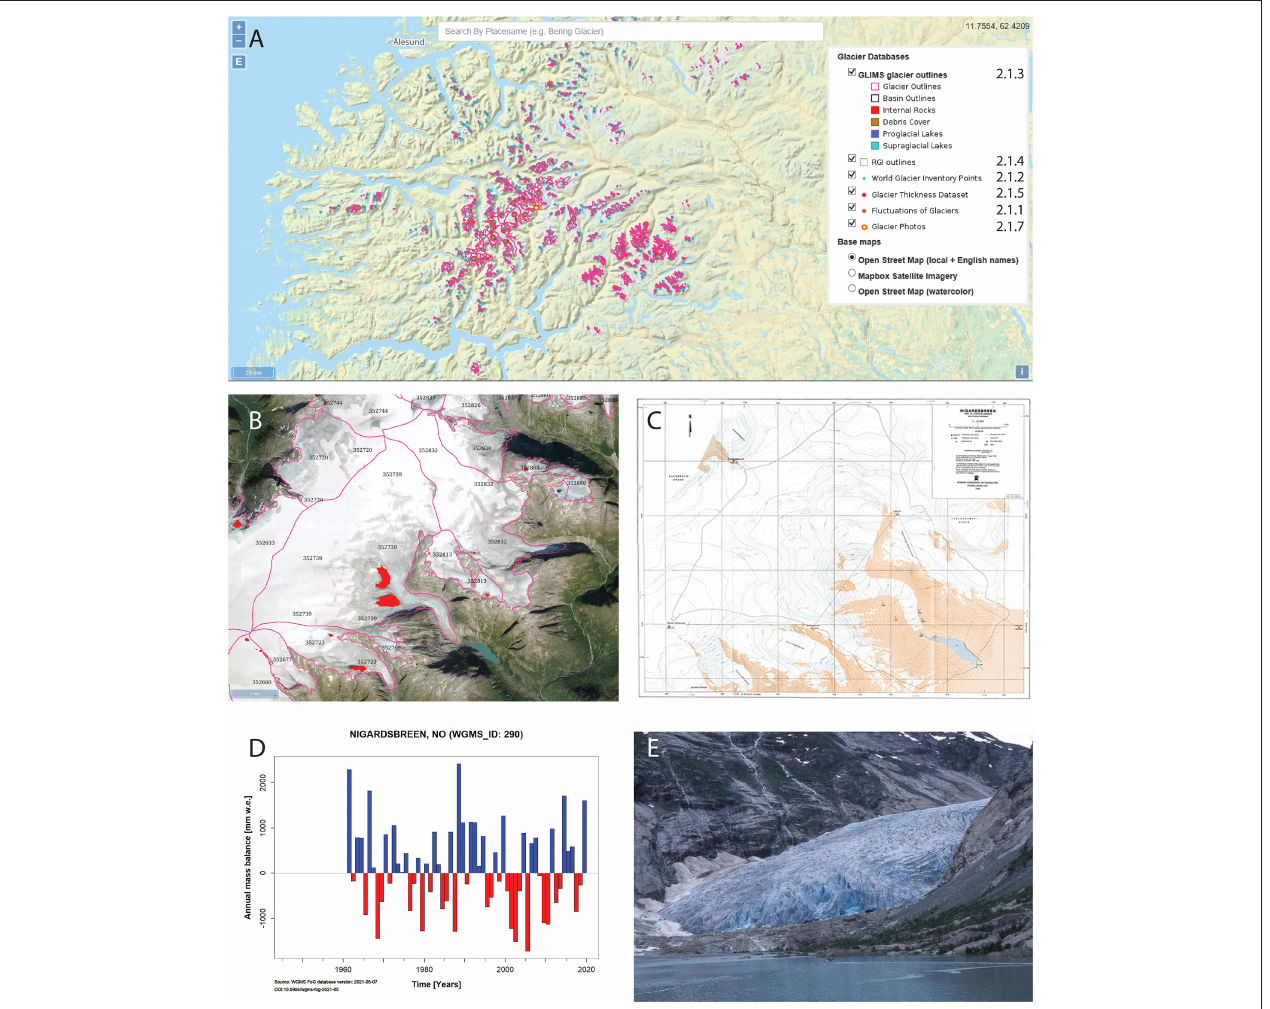
FIGURE 1 | (A) The GTN-G data browser (zoomed) showing available glacier data for a region in southern Norway. The legend shows the different datasets and the related sections in this paper where the datasets are described. Examples are given for Nigardsbreen, an outlet glacier of the Jostedalsbreen ice cap (Norway), as represented in different glacier datasets accessible via the GTN-G data browser: (B) GLIMS outlines as of 2006 (ID: 352739); (C) topographic map of Nigardsbreen as of 1998 (Norwegian Water Resources and Energy Directorate, NVE); (D) annual mass balance since 1960 (B. Kjøllmoen and colleagues, NVE; WGMS, 2021a); (E) photo of the glacier tongue as of August 3 rd , 2000 (E. Roland; Glacier Photograph